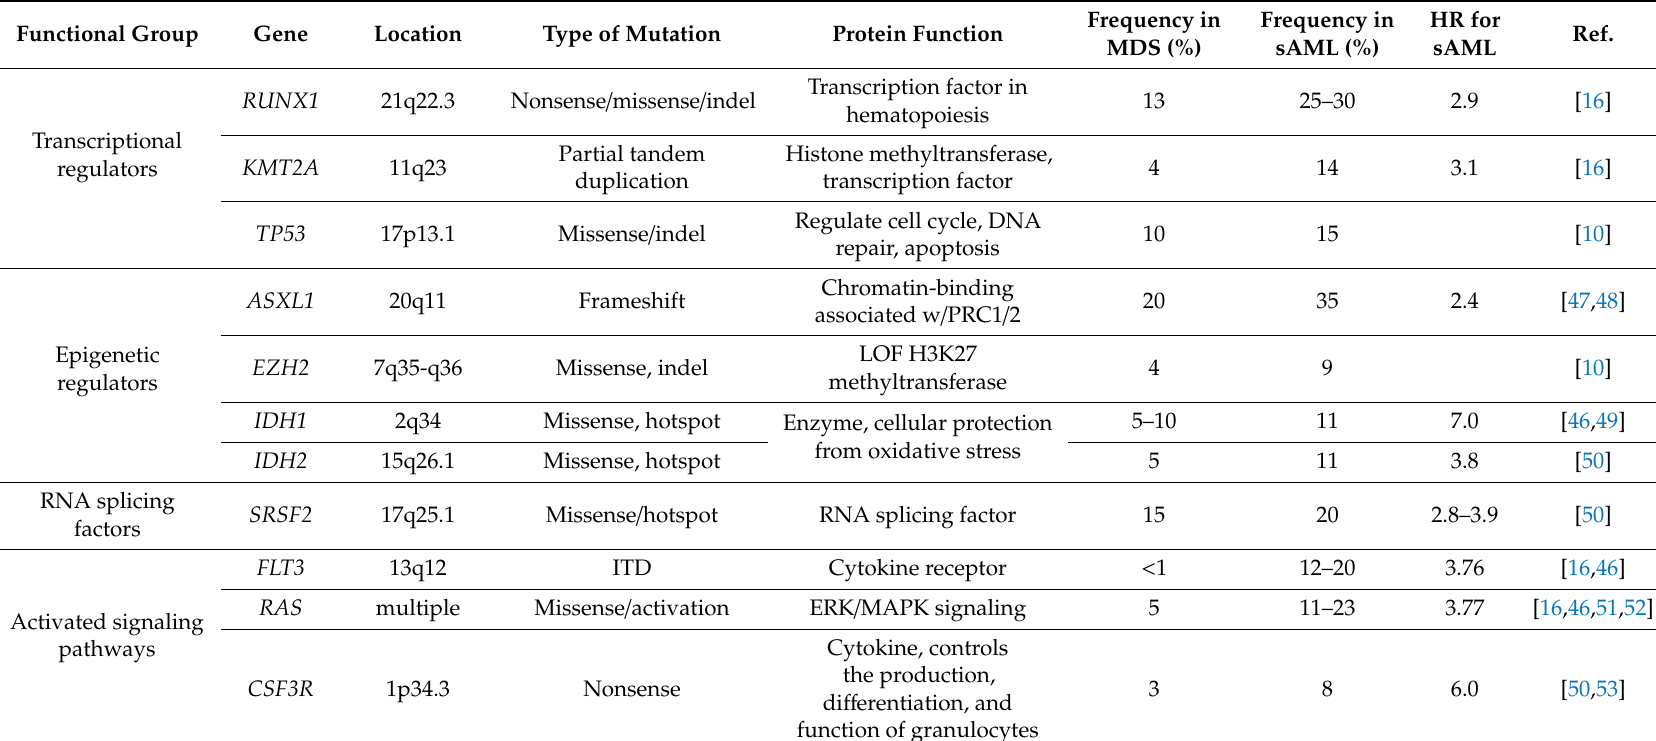
Table 3. Mutations implicated in leukemic progression from myelodysplastic syndrome